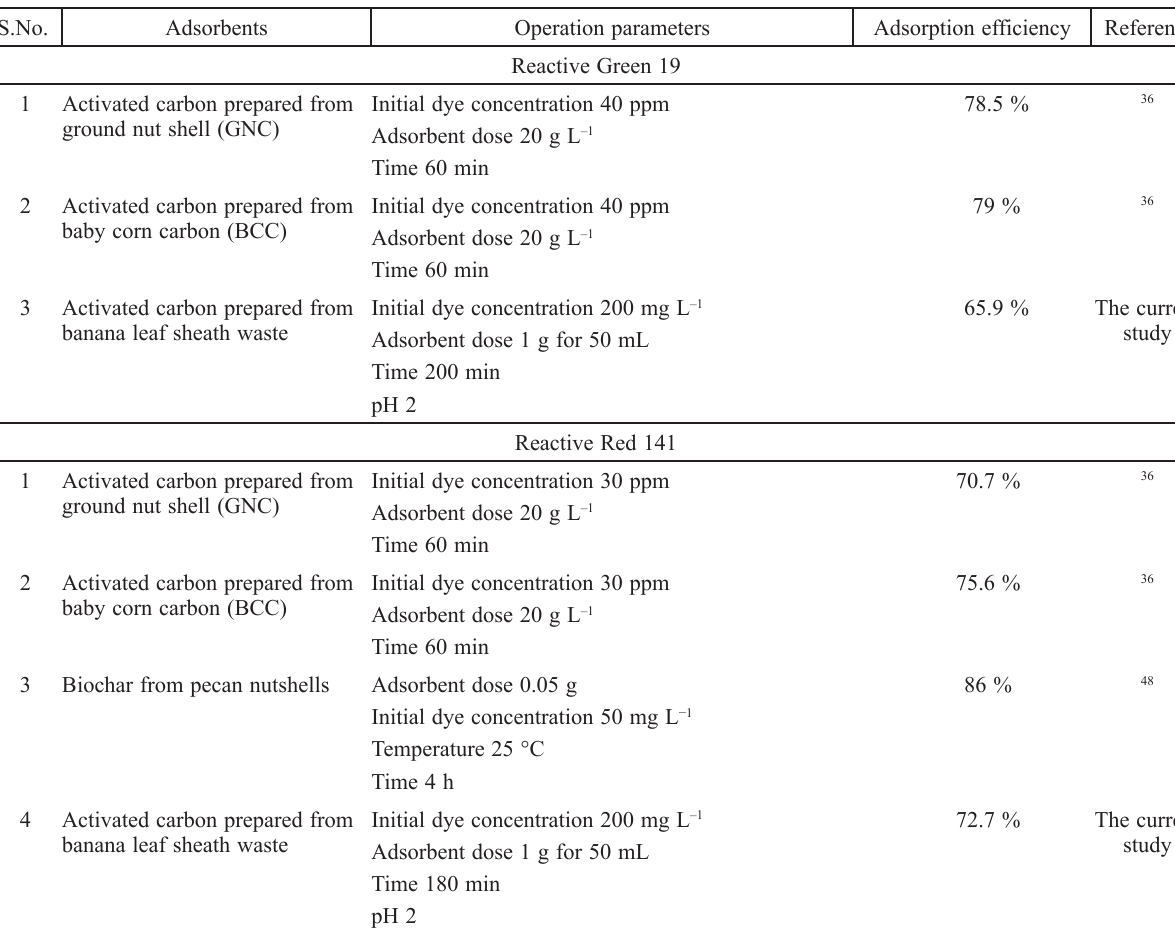
Table 3 – Percentage removal of reactive dyes by adsorbents reported in the literature S.No.